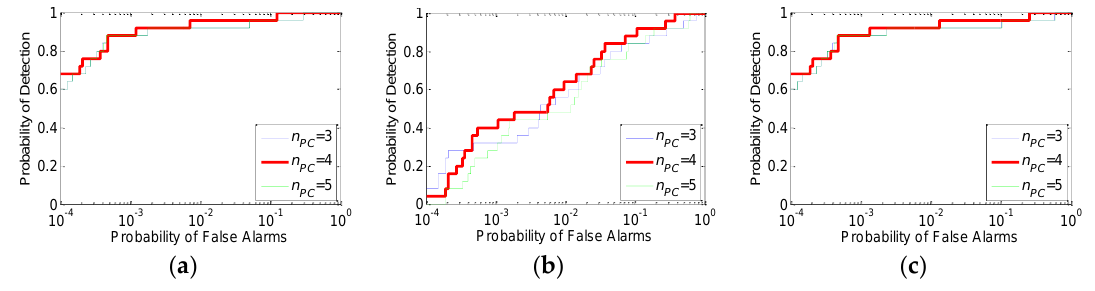
Figure 3. ROC curves with different PC numbers: ( a ) CEM; ( b ) ACE; and ( c ) AMF. Table 2. AUCs of ROC curves for TPCA-based TD with different numbers of PCs. TD Algorithm